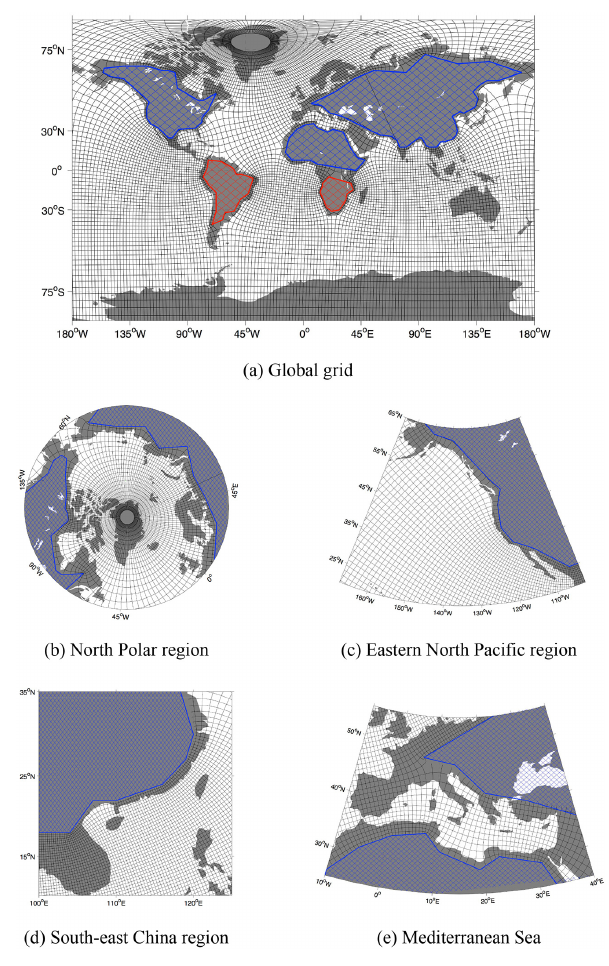
Figure 12. Global grid with MCSC